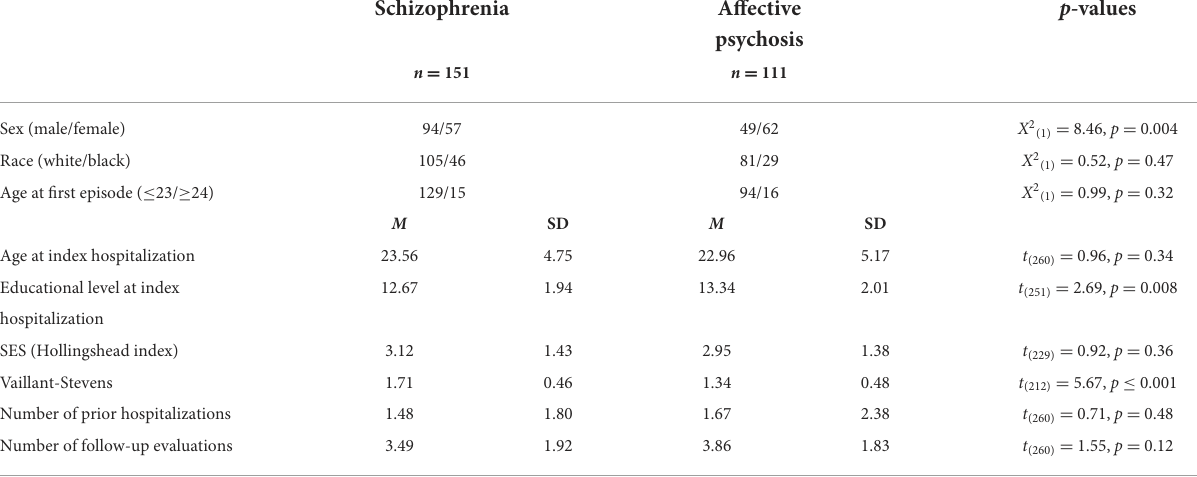
TABLE 1 Demographic and descriptive